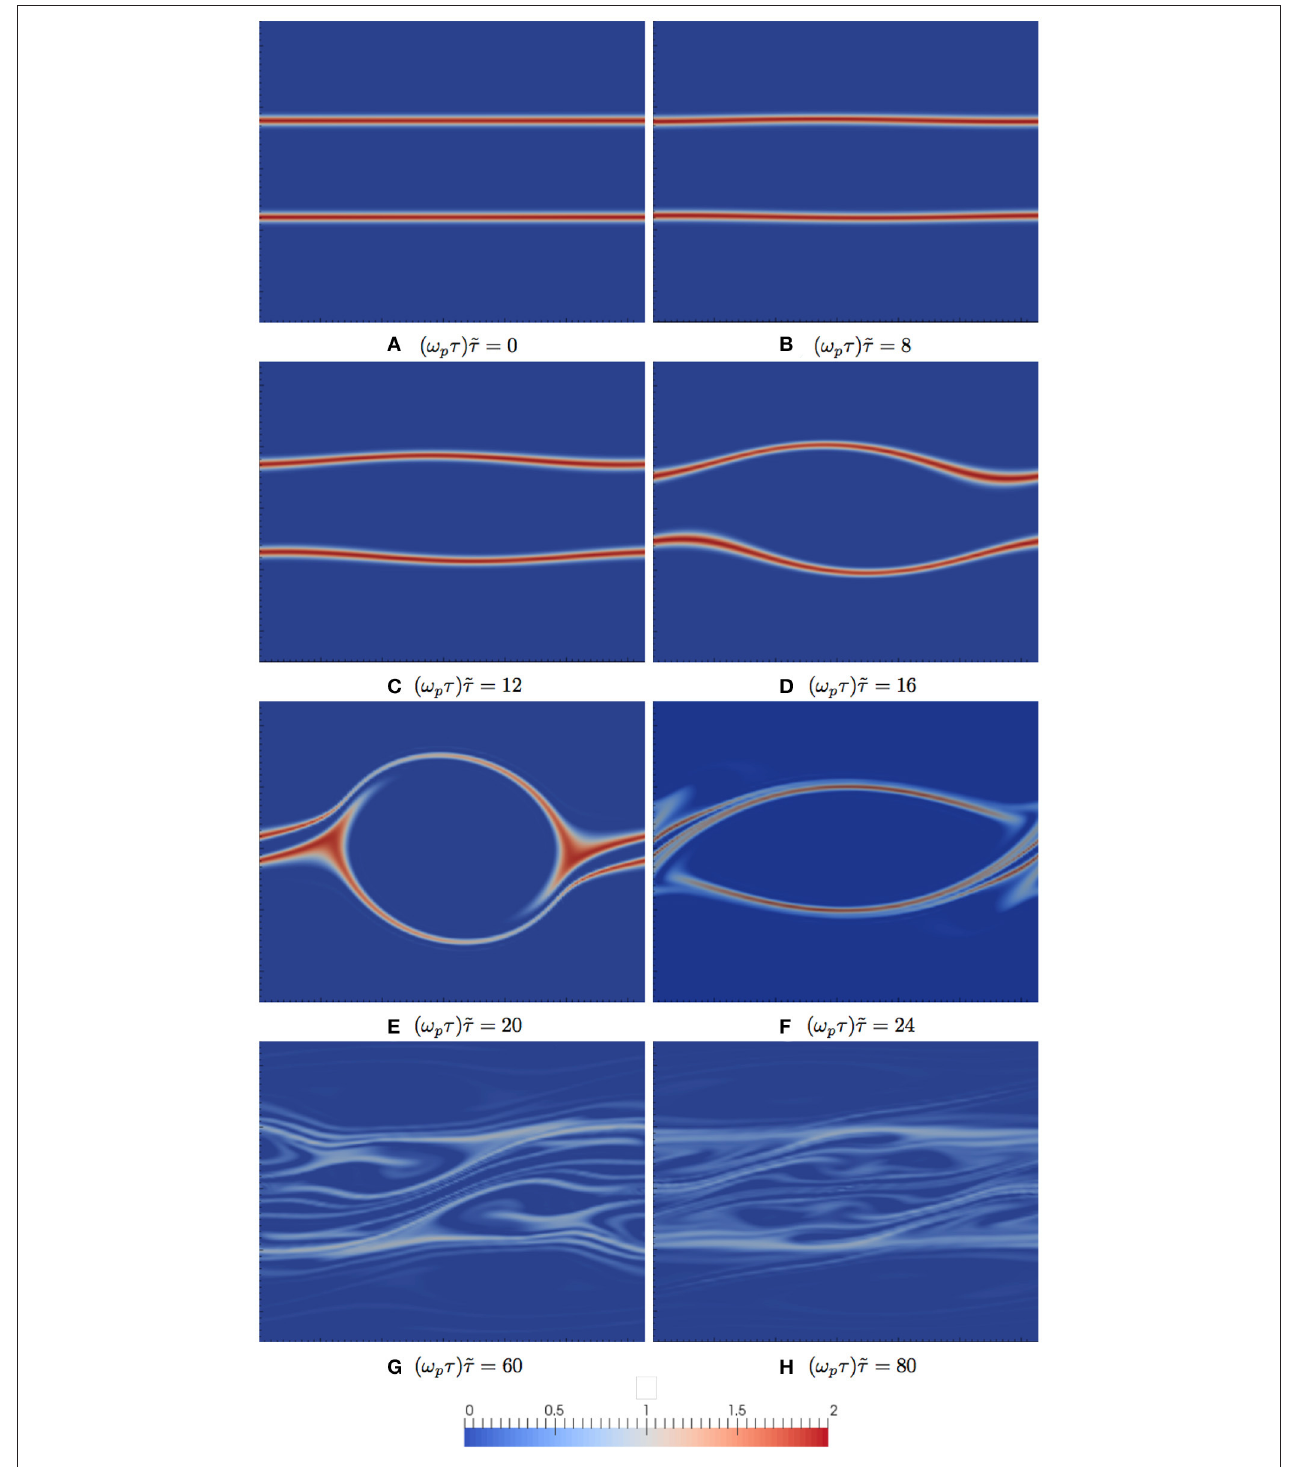
π/ 2 at different times. x =